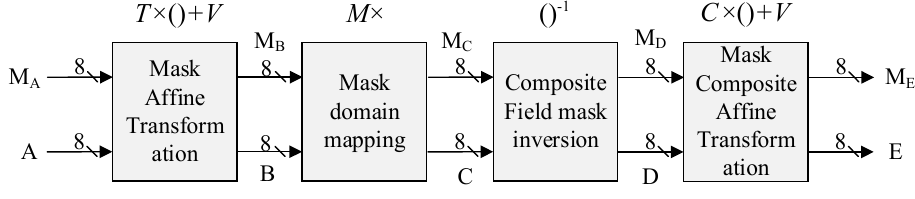
Figure 4. Composite Field mask S-box circuit structure diagram.